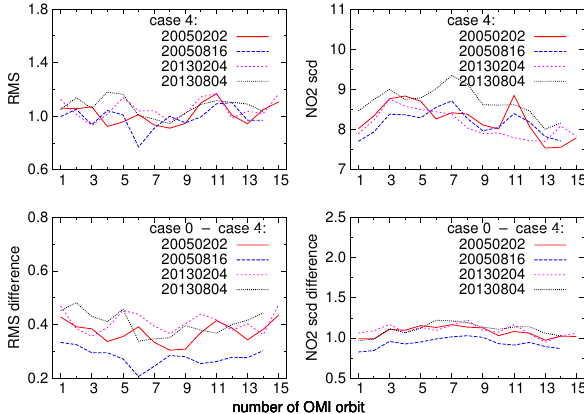
Figure 4. Absolute differences in the NO 2 SCD as a function of Fig.4. AbsolutedifferencesintheNO 2 SCDasfunctionoflatitudeaveragedoverall15orbits. Thecasenum- bersrefertothecaseslistedinTable4,similartothebottompanelsofFig.3. Forcomparison,theconcentration latitude averaged over all 15 orbits. The case numbers refer to the ofO 2 –O 2 asfunctionoflatitudeisshowninarbitraryunits(greenshort-dashedline). cases listed in Table 4, similar to the bottom panels of Fig. 3. For comparison, the concentration of O 2 –O 2 as a function of latitude is shown in arbitrary units (green short-dashed line).